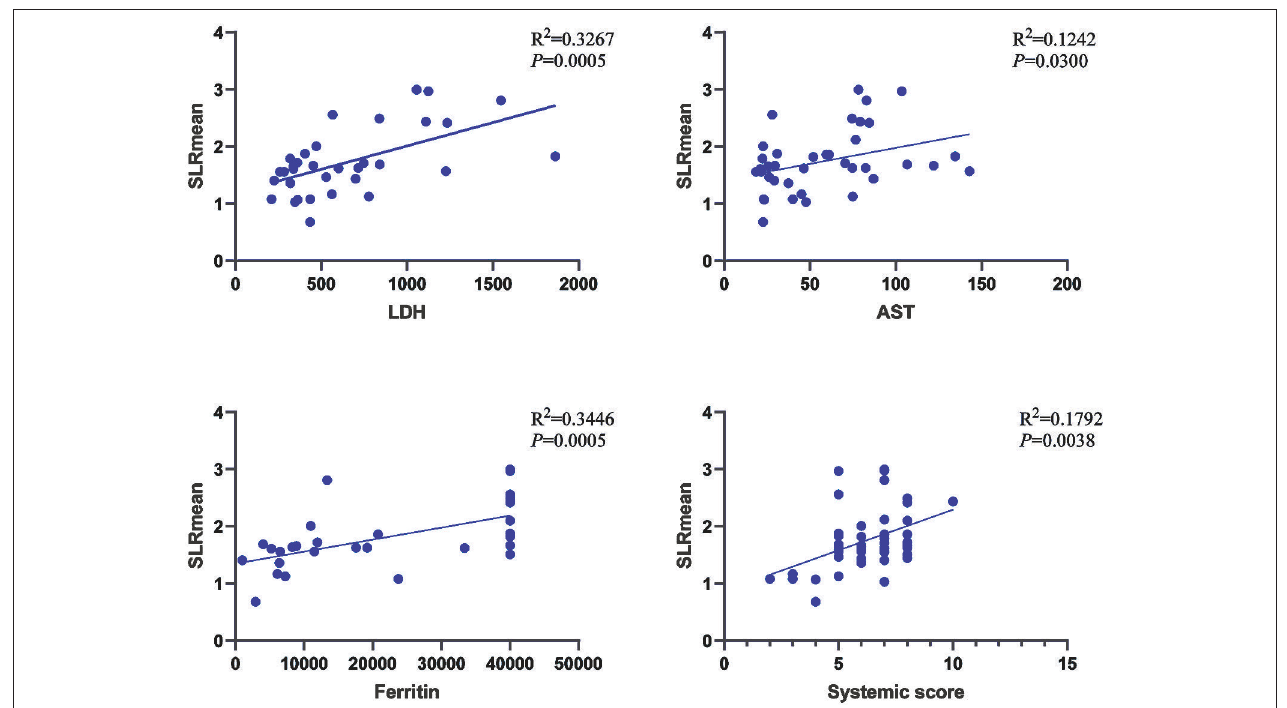
FIGURE 3 | SLRmean correlated positively with LDH, AST, ferritin, and systemic score ( P < 0.05).